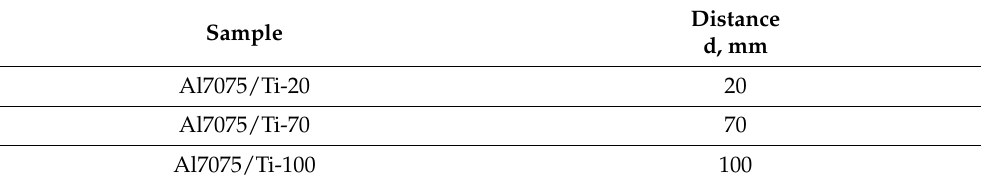
Table 1. Sample name, and distance of nozzle from sample surface.